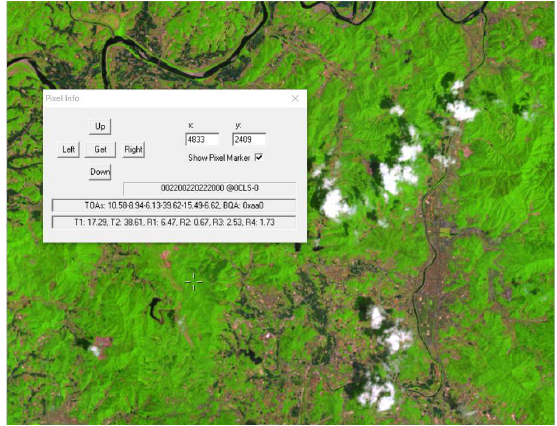
Figure 4. Example of using a software tool to identify SSP and supporting variables. The Pixel info windows shows SSP code, number of SSP codes available within the image, pixel vector in TOA reflectance and values of seven supporting variables. 2.3.3